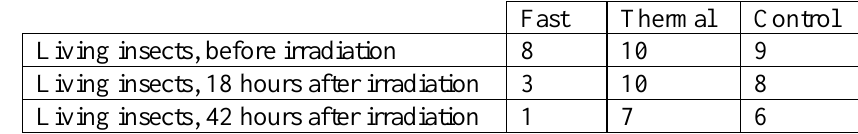
Table 3: Number of living crickets in each group before and after